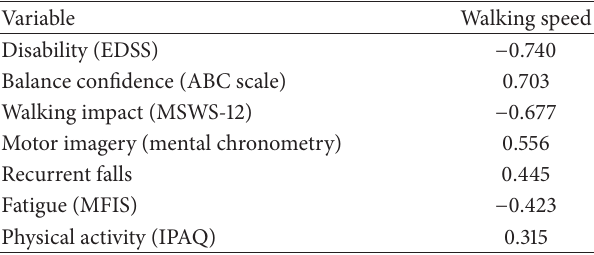
Table 2: Mainly walking speed correlations